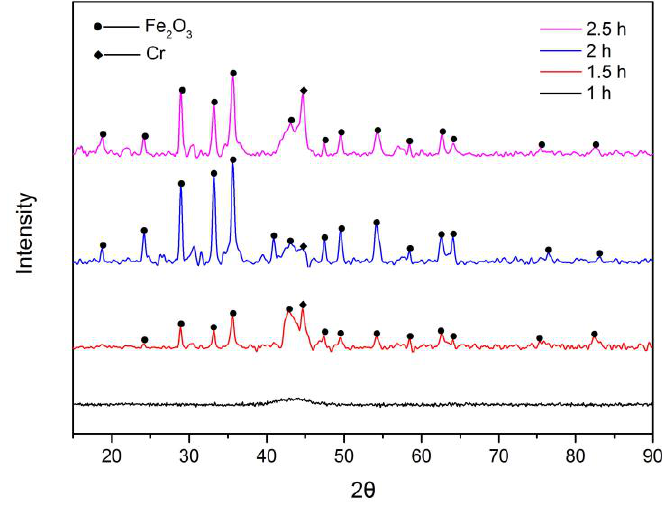
Figure 11. XRD patterns of sintered parts for different holding times.